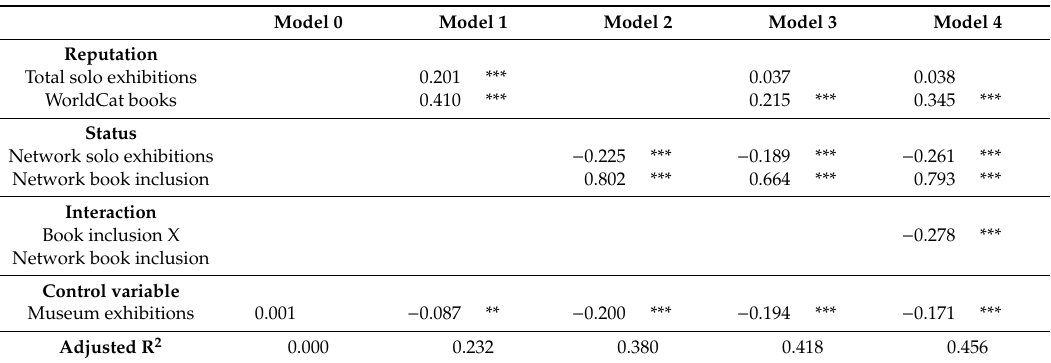
Table 3. Ordinary least squares (OLS) regression results, showing e ff ects on the highest auction price (log transformed) and reporting the standardized coe ffi